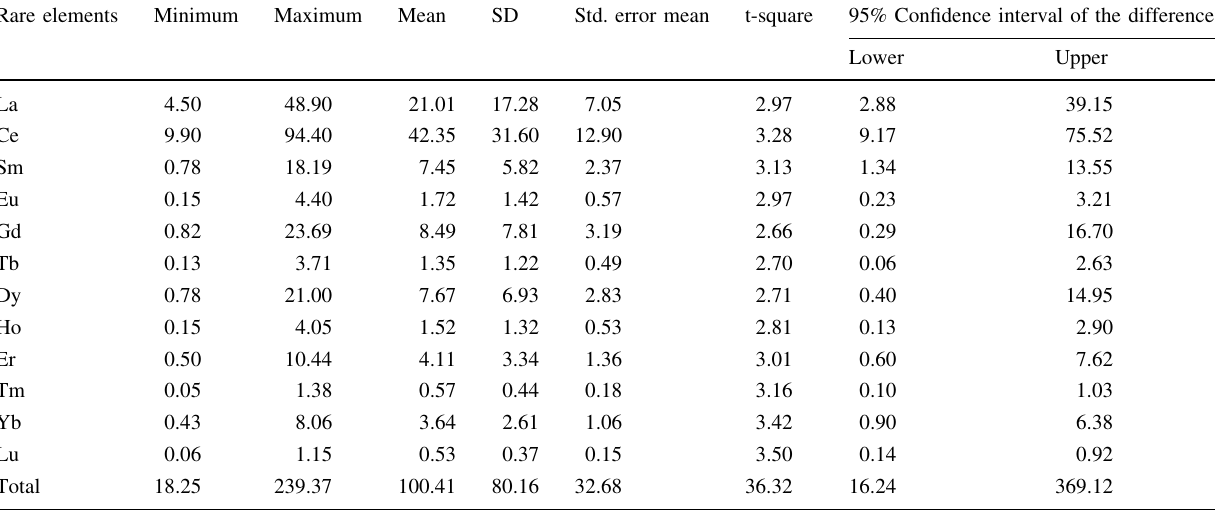
Table 6 Descriptive statistics of rare earth elements in coal Rare elements Minimum